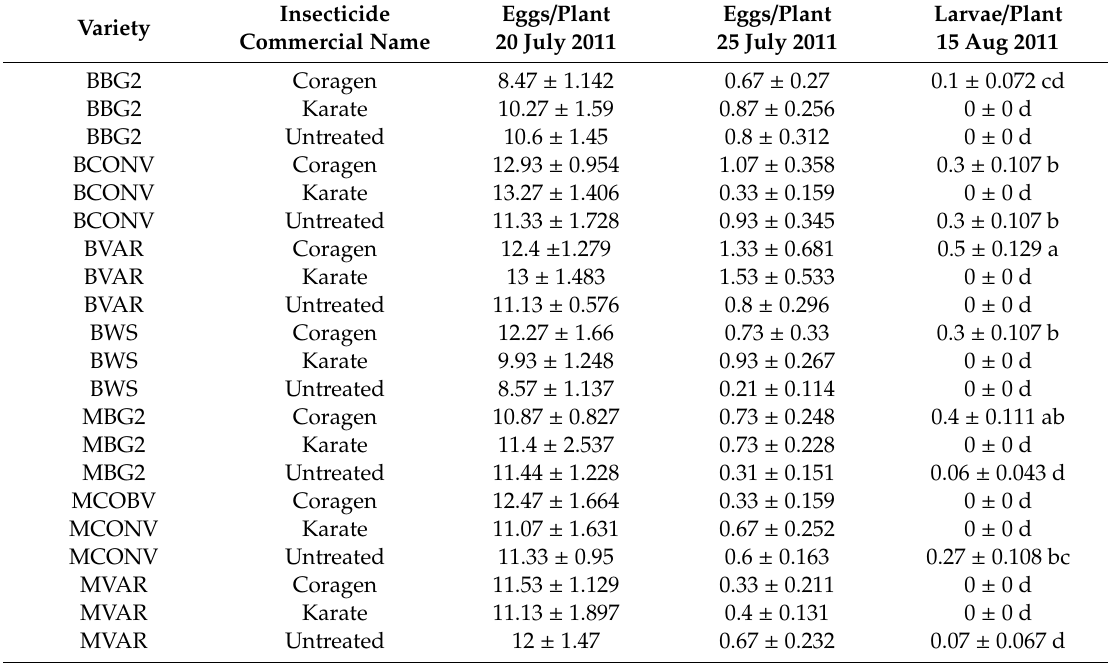
Table 2. Mean insect densities ± SEM observed in cage study plots in 2011. Means not followed by a common letter indicate significant di ff erences between treatments based on LSD at p <